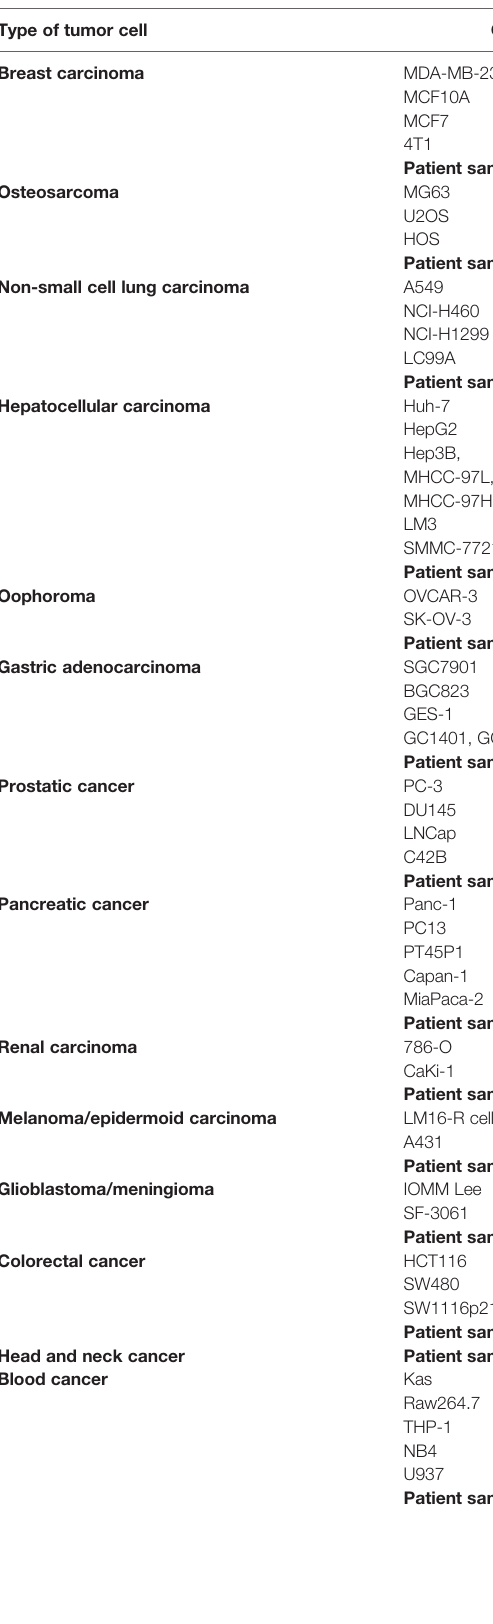
TABLE 1 | Expression of CCR2 and CCL2 by human tumor lines and patient